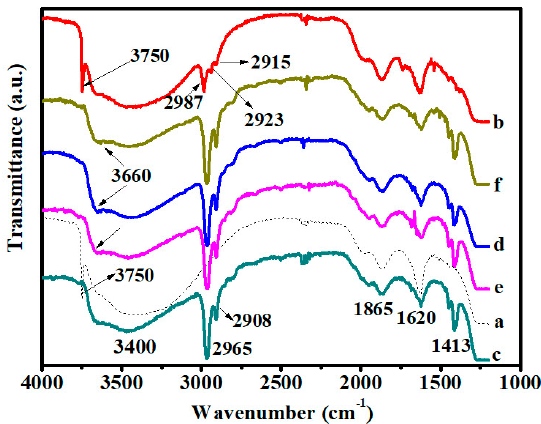
Figure 3. IR spectra of (a) neat fumed silica; (b) fumed silica modified with neat DEC; and (c) silica modified with neat poly(dimethylsiloxanes) (PDMS)-50; (d) PDMS-20 and ((e,f) respectively) their mixtures with DEC at 220 °C for 2 h.